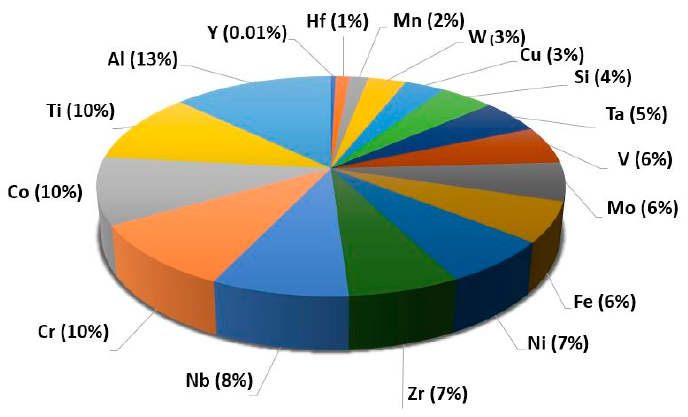
Figure 2. Selected elements used as feedstock for HEFs deposited by magnetron sputtering.